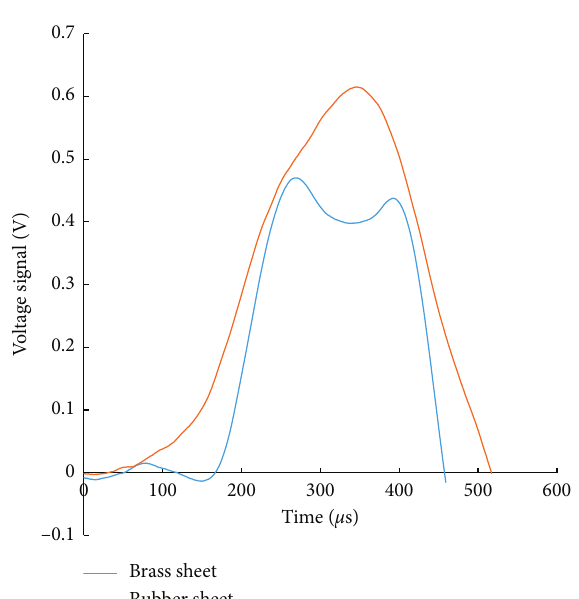
Figure 3: Incident waveform of two pulse